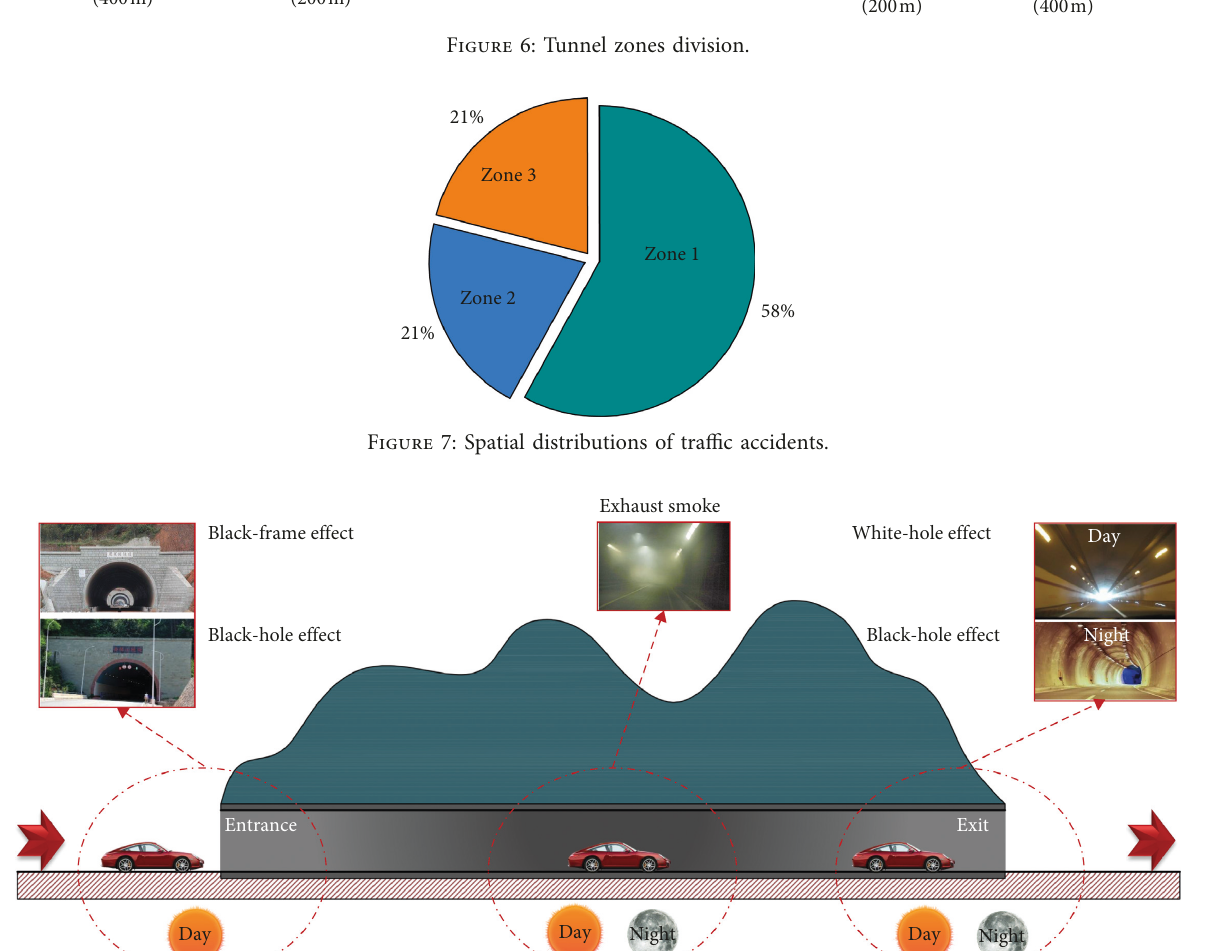
Figure 6: Tunnel zones division.